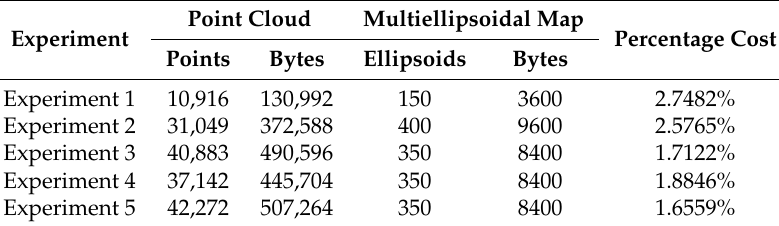
Table 2. Memory cost of the representation—part 1.